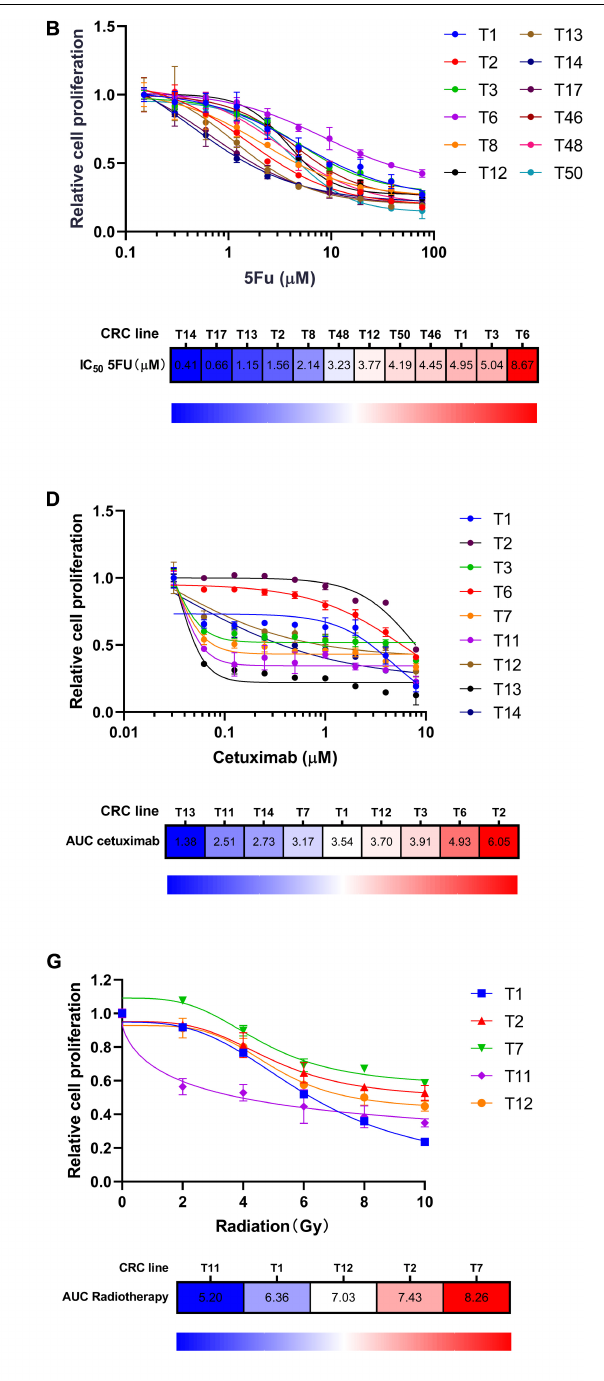
FIGURE 2 | CRC lines as a platform for chemotherapy and radiotherapy sensitivity assay. (A–C) CRC lines revealed variable sensitivity to cisplatin, 5FU, and paclitaxel. Relative cell proliferation was plotted on the y -axis for different concentrations of drugs ( x -axis). Heat maps indicated the CRCs ranking according to drug IC50. Red indicated high IC50 values; blue indicated low IC50 values. (D) CRC lines exhibited variable sensitivity to cetuximab. Relative cell proliferation was plotted on the y -axis for different concentrations of cetuximab ( x -axis). Heat map showing the CRC lines ranked based on cetuximab sensitivity as measured by AUC. Red indicated high AUC values; blue indicated low AUC values. (E) Heat map showing Z factor scores of the performed drug screens for all drugs and all CRC lines presented in this study. (F) The consistency of cisplatin killing effects among different-passage CRC lines. 4 CRC lines were used to compare. (G) CRC lines revealed differential sensitivity to radiation. Relative cell proliferation was plotted on the y -axis for different amounts of radiation, ranging from 0 to 10 Gy ( x -axis). Heat map showing the CRC lines ranked according to radiotherapy sensitivity as measured by AUC. Red indicated high AUC values; blue indicated low AUC values.